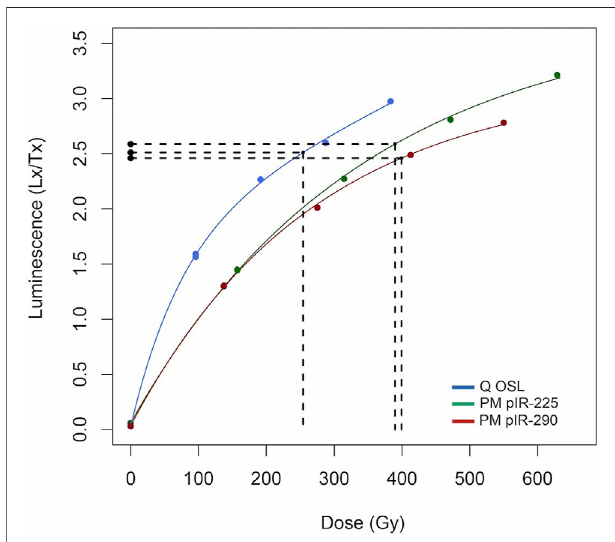
FIGURE 3 | Typical growth curves of one aliquot each of sample Gi549, showing Lx/Tx values, Ln/Tn values and the respective palaeodoses for the quartz fi negrainfraction,andthepolymineral fi negrainfractionmeasured with an pIRIR-225 and an pIRIR-290